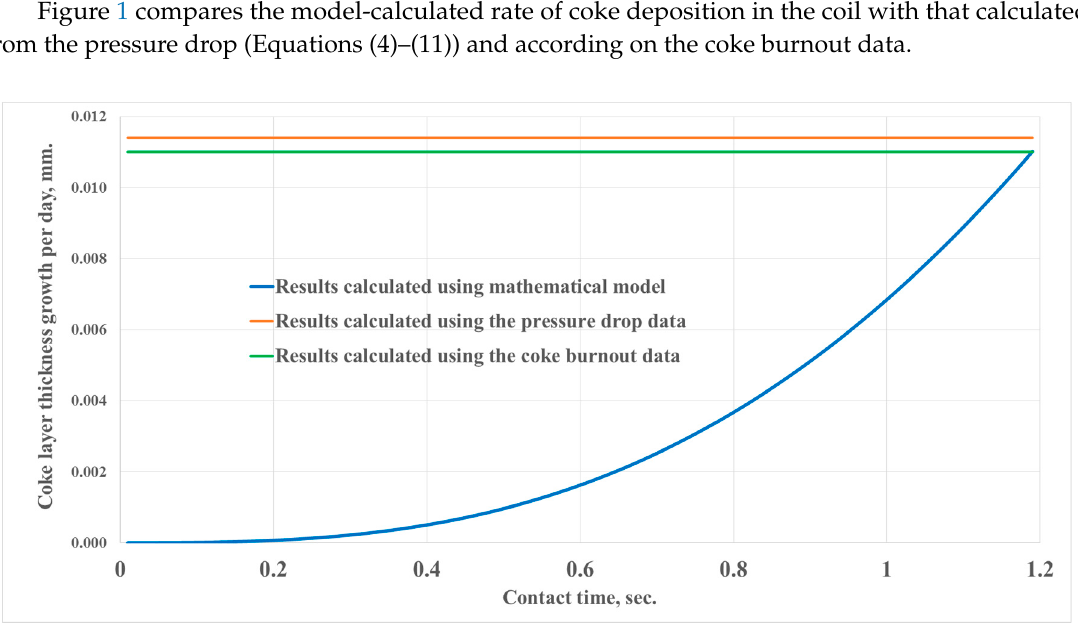
Figure 1. Thickness of coke layer accumulated each day depending on the contact time (coil length).